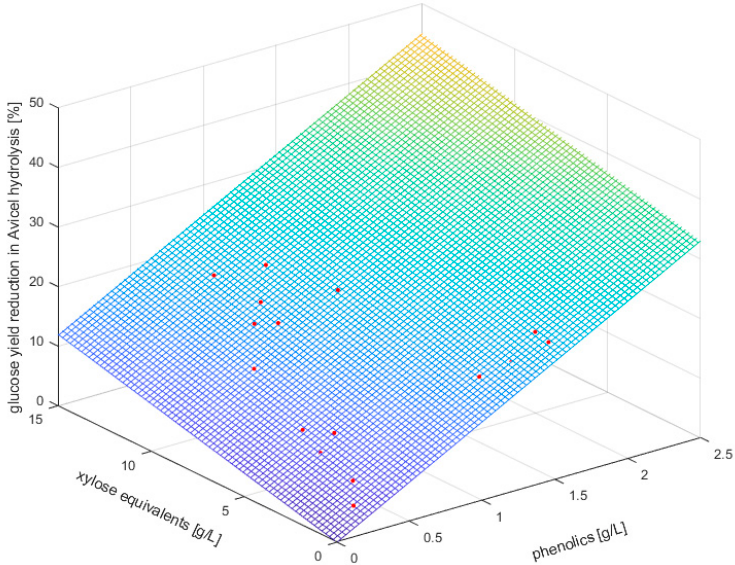
Figure 11. Calculated final yield reduction in enzymatic hydrolysis of Avicel as a function of the concentration of the sum of xylose and xylooligomers and of the phenolics concentration in the enzymatic hydrolysis mixture. Shown is the calculated inhibition plane based on Equation (2) together with the measured data points in red.